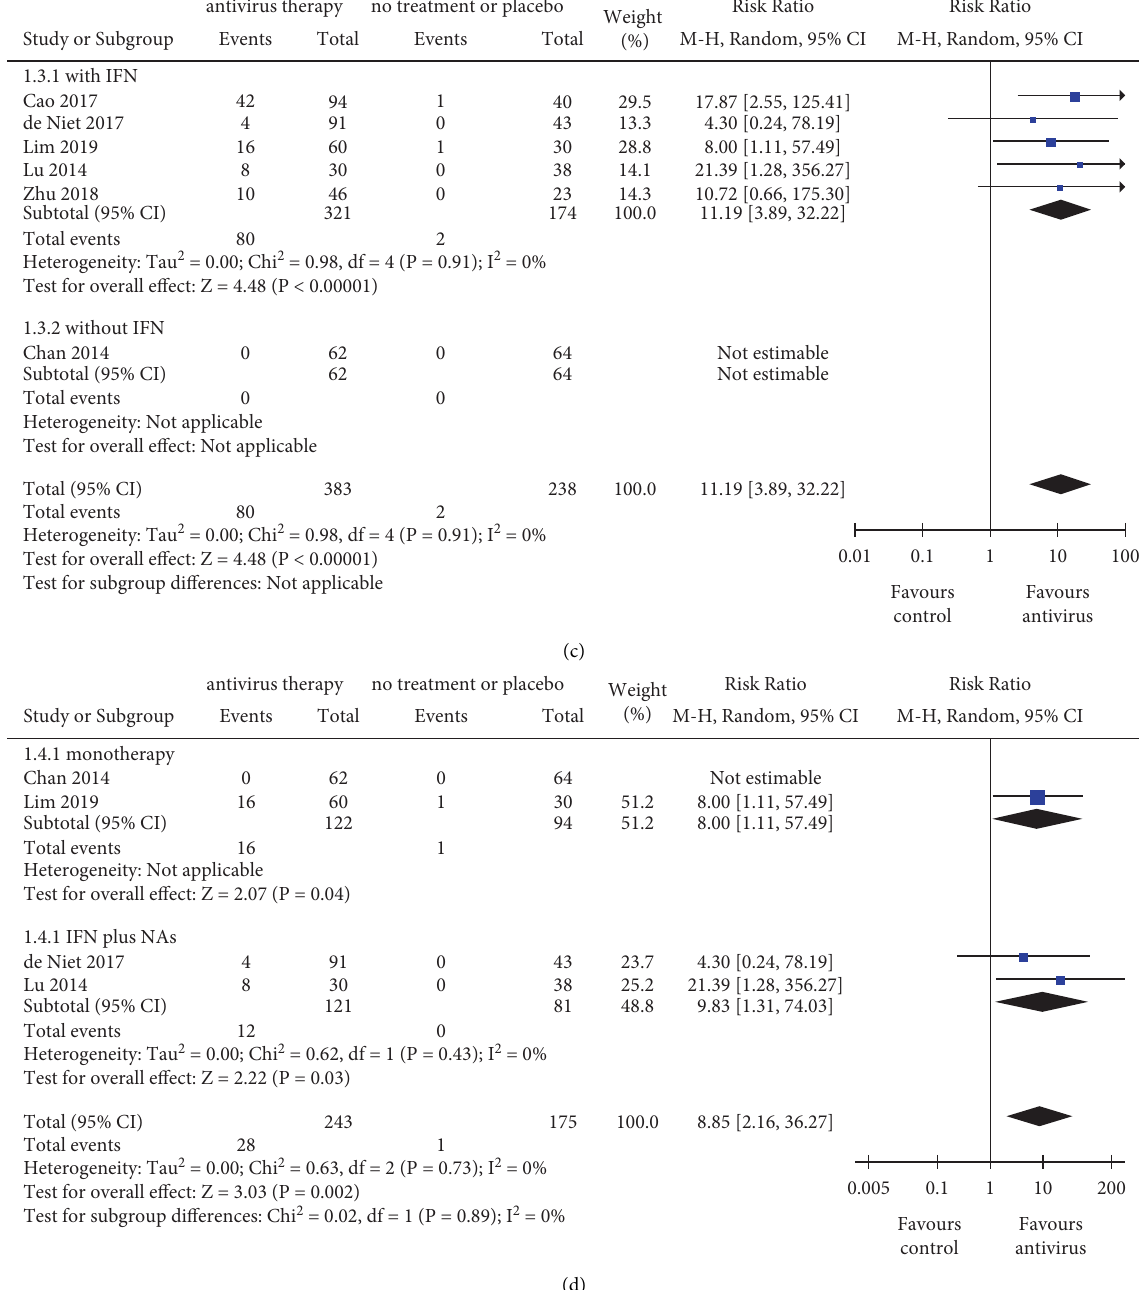
Figure 2: Te outcomes of HBsAg loss. (a) Pooled risk ratio for HBsAg loss between the antiviral therapy group and control group. (b) Subgroup analysis stratifed by patients’ baseline parameters (the status of HBeAg and the level of HBV DNA). (c) Subgroup analysis stratifed by therapeutic regimen with or without IFN. (d) Subgroup analysis stratifed by monotherapy and combined therapy (IFN plus NAs). NAs, nucleos(t)ide analogs; IFN, interferon; CI, confdence interval; monotherapy exclusively included NAs or IFN. Te size of square represents the weight of each study, and the vertical dotted line represents the pooled